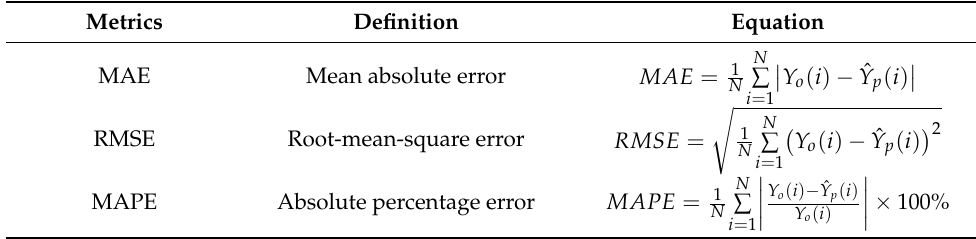
Table 2. Three error